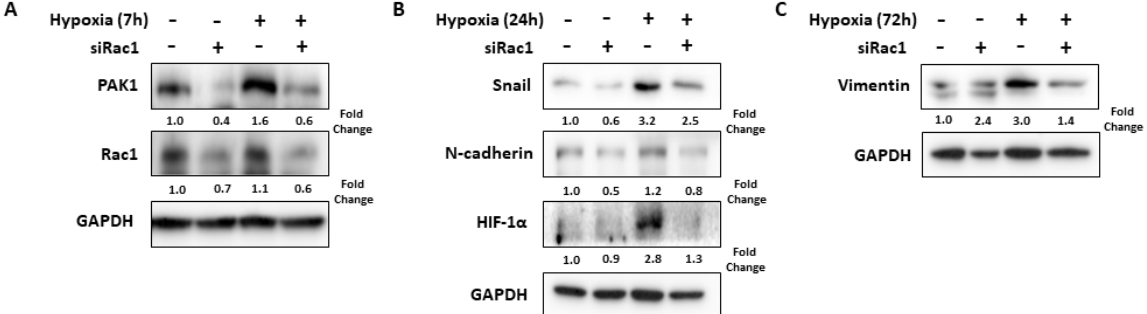
Figure 3. Rac1 knockdown decreases the expression of PAK1/Snail in hypoxia-exposed Hep3B cells. Hep3B cells were transfected with Rac1 siRNA or NC siRNA and incubated in normoxic or hypoxic conditions for 7–72 h. ( A ) Hypoxia induced increase of PAK1 and Rac1 expressions, and Rac1 knockdown decreased the expression of PAK1. ( B ) Hypoxia increased Snail, N-cadherin, and HIF-1 α expression, and Rac1 knockdown decreased the expression of Snail, N-cadherin, and HIF-1 α . ( C ) Hypoxia augmented Vimentin and Rac1 knockdown inhibited the expression of Vimentin. EMT, epithelial–mesenchymal transition; GAPDH, glyceraldehyde-3-phosphate dehydrogenase; HIF, hypoxia-inducible factor; NC, negative control; PAK, p21-activated kinase.